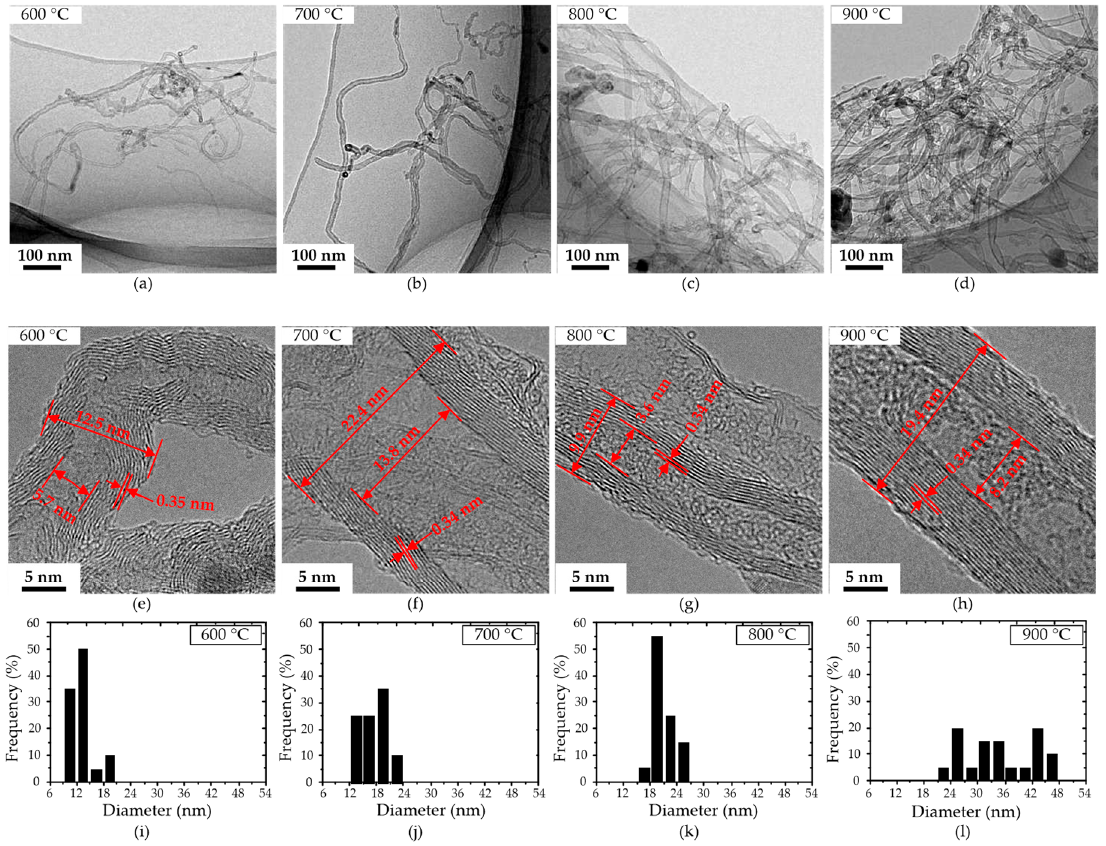
Figure 4. HRTEM images of CNTs grown on the aluminum foil at 600, 700, 800, and 900 °C. ( a – d ): low-magnification images; ( e – h ): high-magnification images; ( i – l ): the diameter distribution of CNTs in ( a – d ).